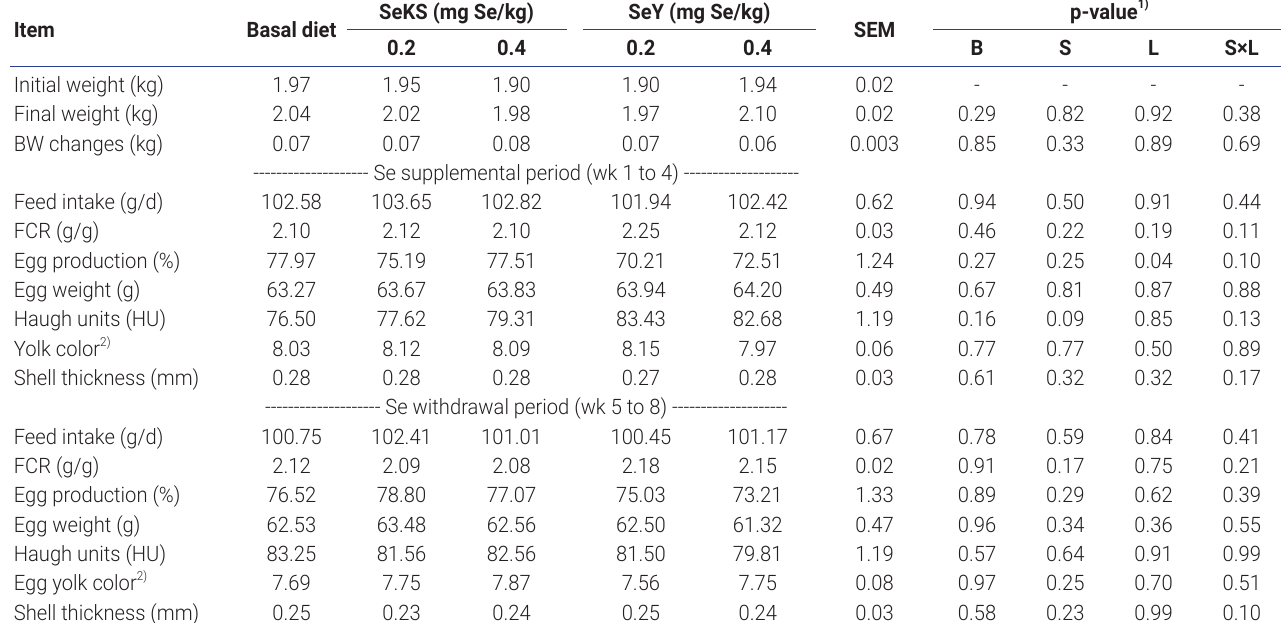
Table 3. Effect of supplementation and withdrawal of selenium sources on performance, egg production and egg quality of laying hens